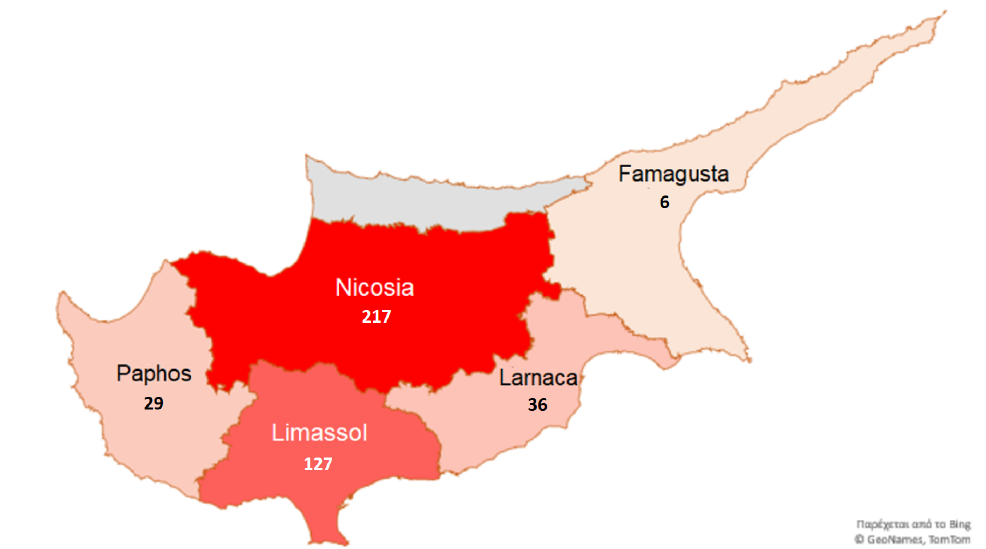
Figure 4. Study Area: Number of participants per province. The colours are relevant to the number of participants per province. The darker the colour is, the more people participated in the study from that province. Please note that the numbers on the map sum up to 415 instead of 416, since the name of residency provided by a participant was